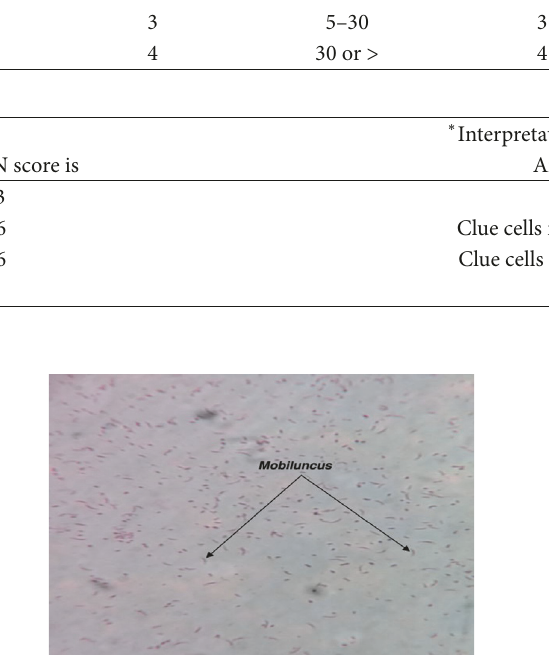
Figure 3: Direct Gram stain of high vaginal swab showing Gram negative curved rods-